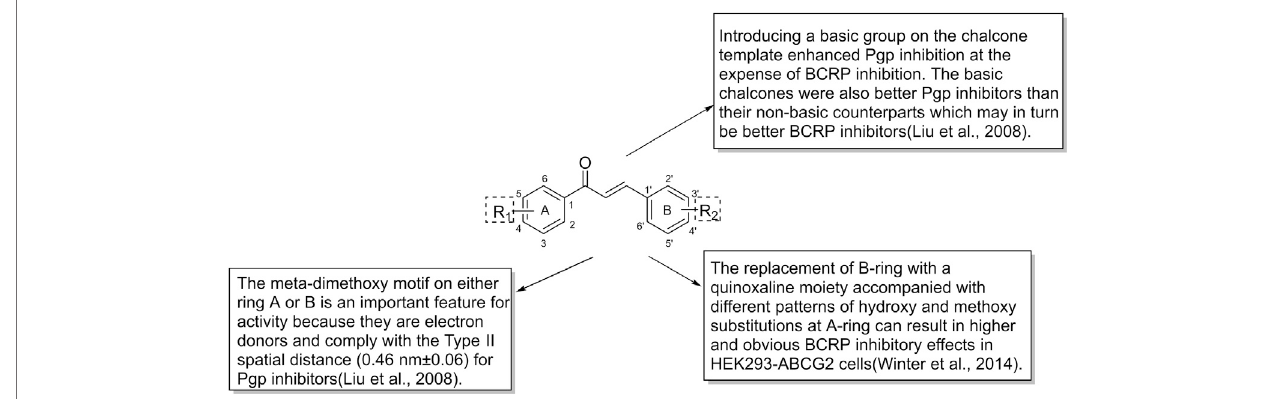
FIGURE 7 | The structure-activity relationship of chalcones as ABC transporter